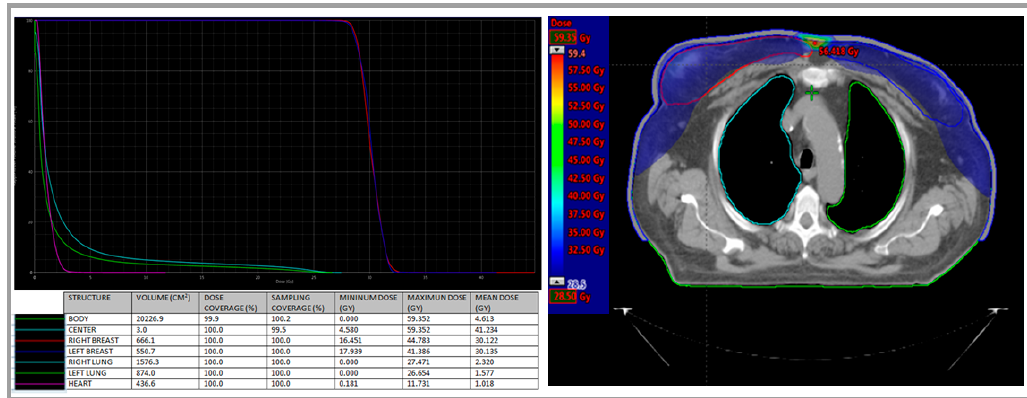
Figure 3. Radiotherapy was performed bilaterally by two opposing fields of 6 MeV photons by Linac D-2300 CD Varian (Palo Alto, CA, USA). The irradiation was administered after placement of a 0.5 cm thick bolus on each breast to limit drastically the “build-up” effect and then insert the skin into the clinical target volume (CTV). A total dose of 30 Gy on each breast was administered. Organ at risk’s dose was reduced to minimize to toxic effects (2.5 Gy to 20% of the right lung; 1.5 Gy to 20% of the left lung; and heart mean dose 1.018 Gy and maximum dose 11.731 Gy).